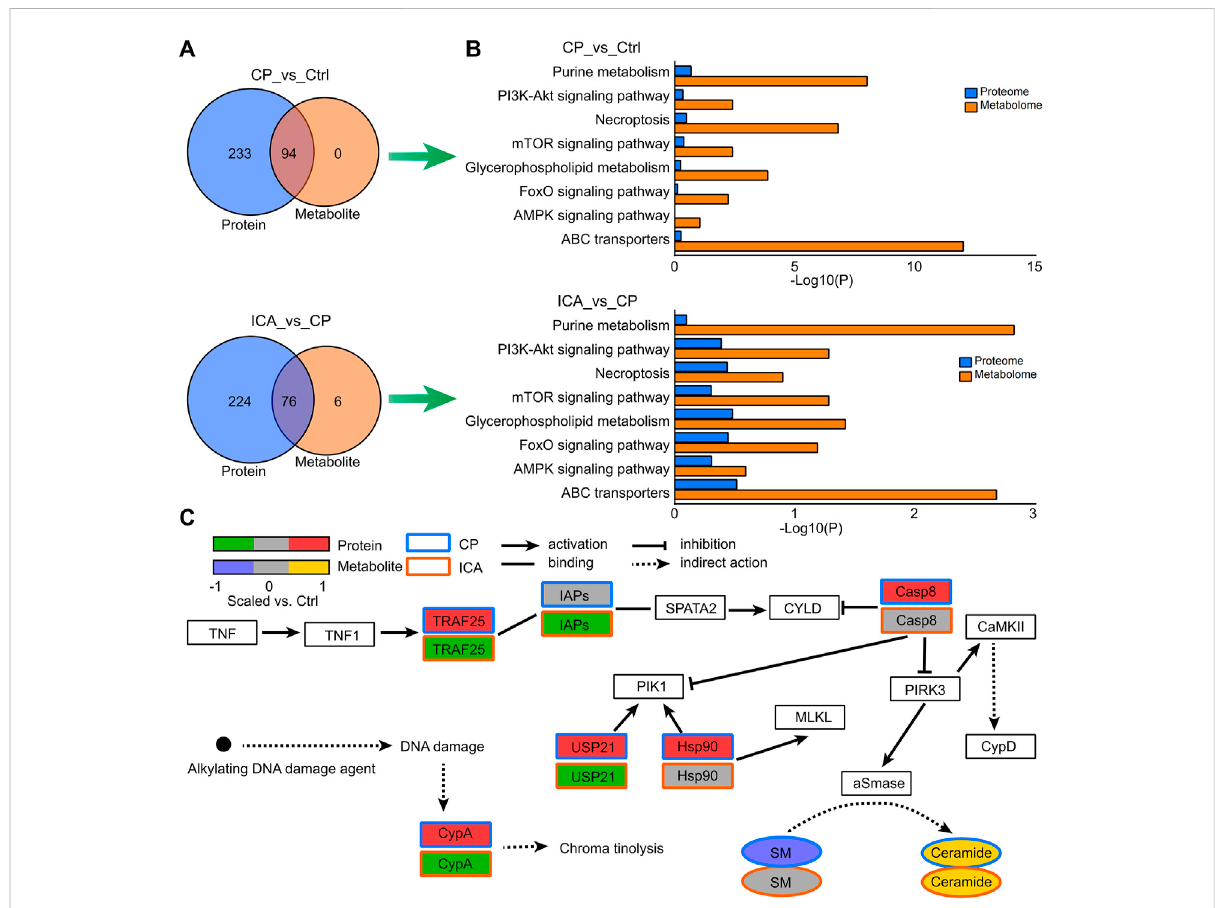
FIGURE 5 Enrichedpathwaysfromthecombinedanalysisofproteomicsandmetabolomicsdata. (A) Venndiagramsillustratingthenumberorproteinand metabolite pathways signi fi cantly changed in “ Ctrl vs. CP ” and “ CP vs. ICA ” . (B) The enriched KEGG pathways in “ Ctrl vs. CP ” and “ CP vs. ICA ” , which were expressed at both the protein and metabolite level. (C) Protein and metabolite modi fi cations in the necroptosis